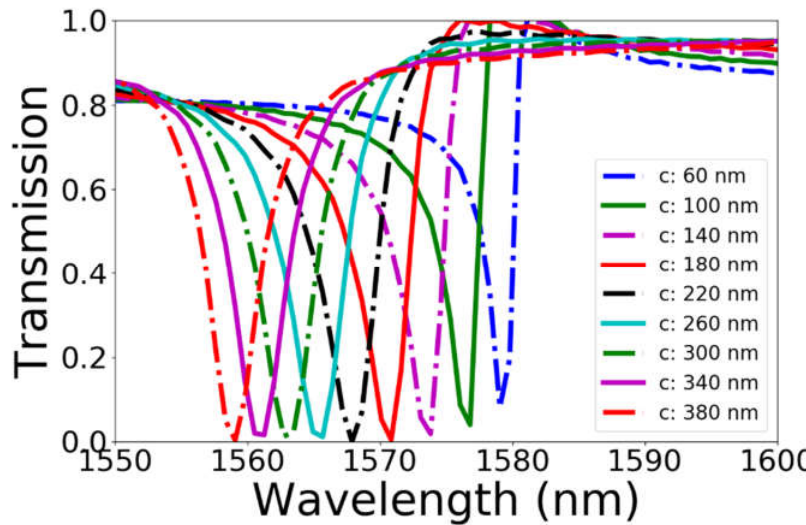
Figure 8. Transmission spectra of PhC-structure with crater-depth varied from 60 to 380 nm. A blueshift along with an increase in the linewidth of the resonant modes can be observed.